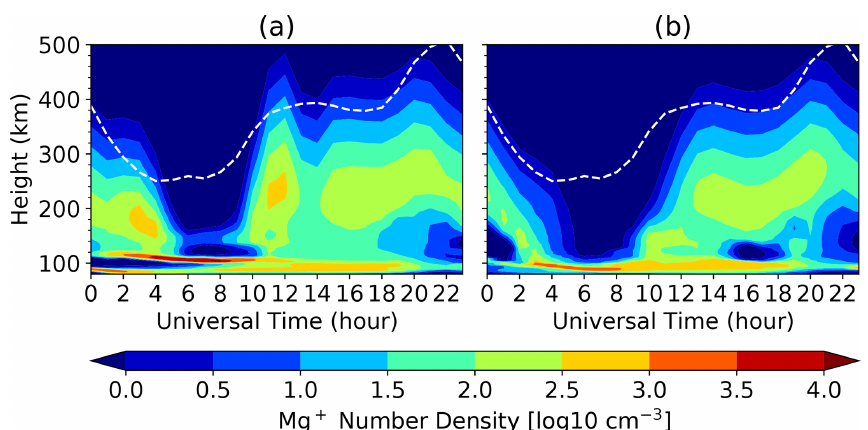
Figure 8. Mg + density over (12 ◦ N, 0 ◦ , near the dip equator) as a function of universal time and altitude at June solstice. The dashed lines denote hmF2. (a) for the TA simulation and (b) for the CE